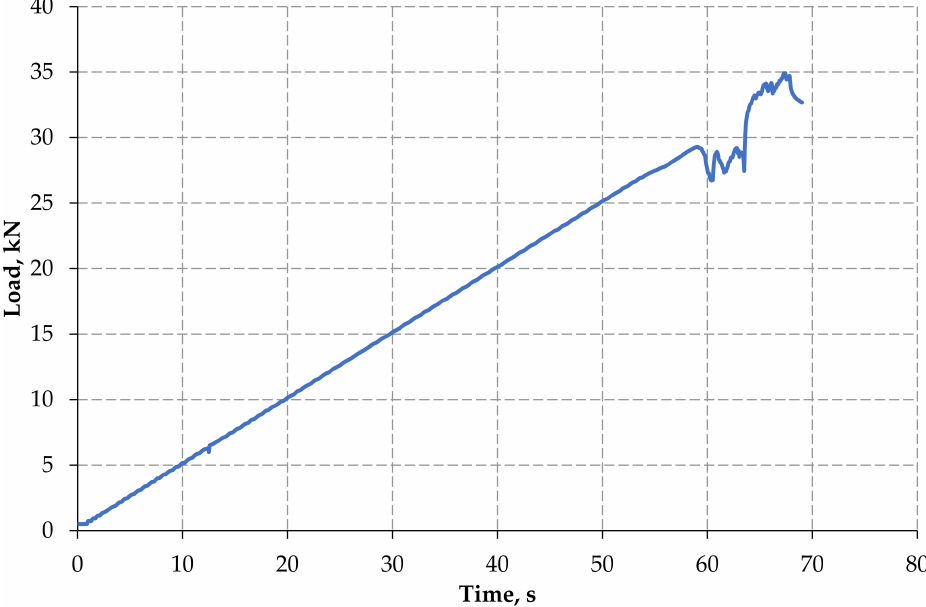
Figure 6. Load history—monotonic